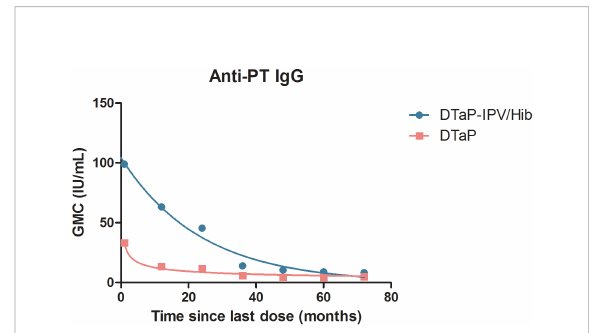
FIGURE 2 The curve fi t of waning anti-PT IgG for the two